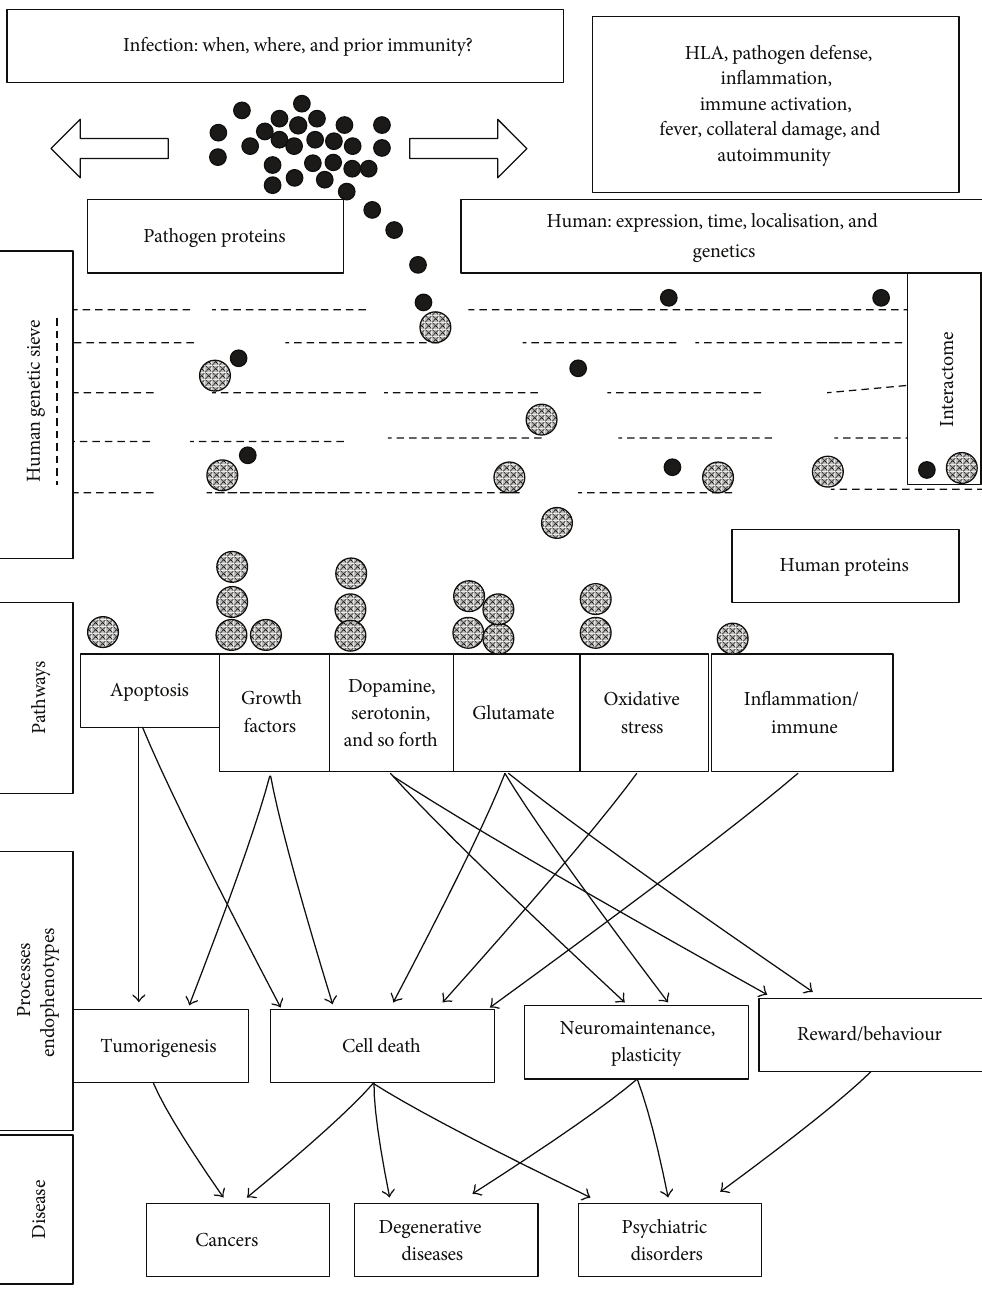
Figure 2: A model of the host pathogen interactome illustrating how multiple gene/environment interactions might direct the attentions of the pathogen towards distinct pathways, processes, and diseases. For any pathogen, immune and pathogen defence pathways as well as inflammatory processes will be activated to counter the infection. Although the pathogen can interact with hundreds of host genes and proteins, those chosen will depend upon the strain of pathogen, the timing and localisation of infection, and on whether prior immune barriers exist. In turn, which human elements are available for interaction will depend upon their expression (time and location) upon their functional quirks dictated by polymorphisms or mutations, and so forth. This selection process, involving a genetic sieve and individual interaction probabilities, enables similar interactome selectivity, allowing the pathogen to specifically affect different series of pathways in different circumstances (illustrated by the number of human proteins ending their route in a particular pathway bin). The differential modification of particular pathways will in turn affect particular processes and endophenotypes, whose final assembly constitutes the eventual mosaic of disease. This triage, involving both human and pathogen genes and proteins, as well as environmental factors, may explain how the same pathogen could cause, prevent, or otherwise influence a variety of diseases, depending upon genetic factors and a series of coincidences (see text for further